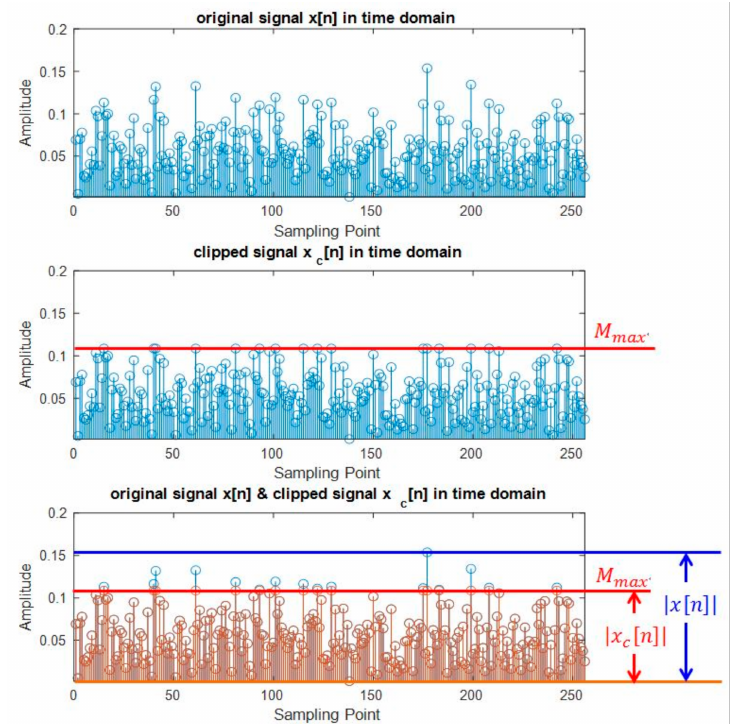
Figure 2. An illustration of the original OFDM signal and its clipped counterpart. Orthogonal frequency-division multiplexing